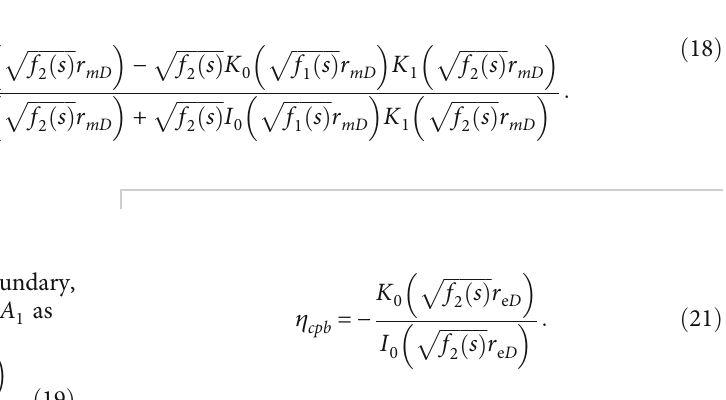
ffiffiffiffiffiffiffiffiffiffi